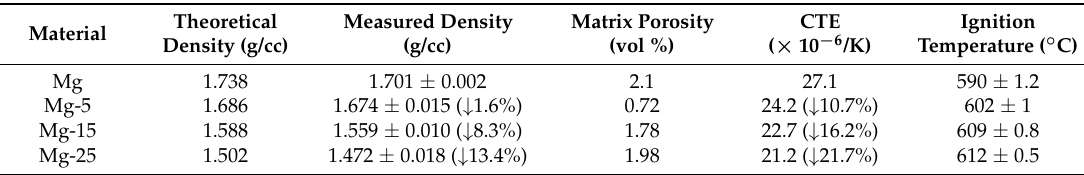
Table 1. Results of density, coefficient of thermal expansion (CTE) and the ignition measurement of Mg and Mg/GMB syntactic foam